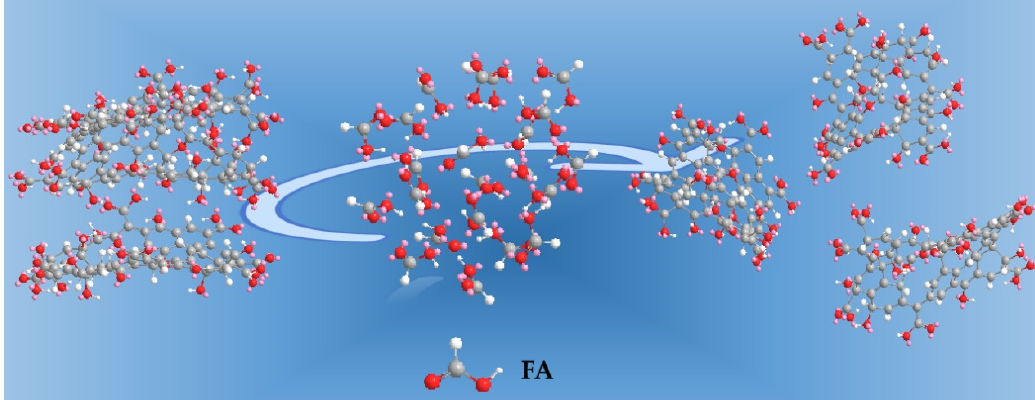
Figure 6. Distribution of GO in acidic solvents.